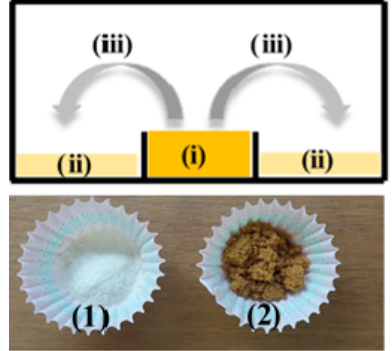
Figure 10. Upper part: Schematic representation of the green evaporation/adsorption process applied for the preparation of BO_CS nanostructure, (i) glass beaker with BO, (ii) spread CS at the bottom of the aluminum beaker, (iii) process of BO evaporation and adsorption into CS. Down part: (1) Image of raw CS powder and (2) modified CS_BO nanostructure .